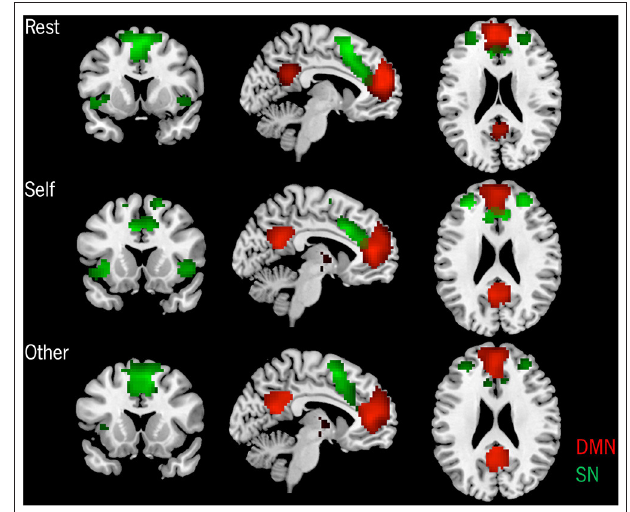
FIGURE 2 | Group-level spatial patterns of the DMN and the SN in the three conditions. p < 0.05 FWE corrected, extent threshold k = 10